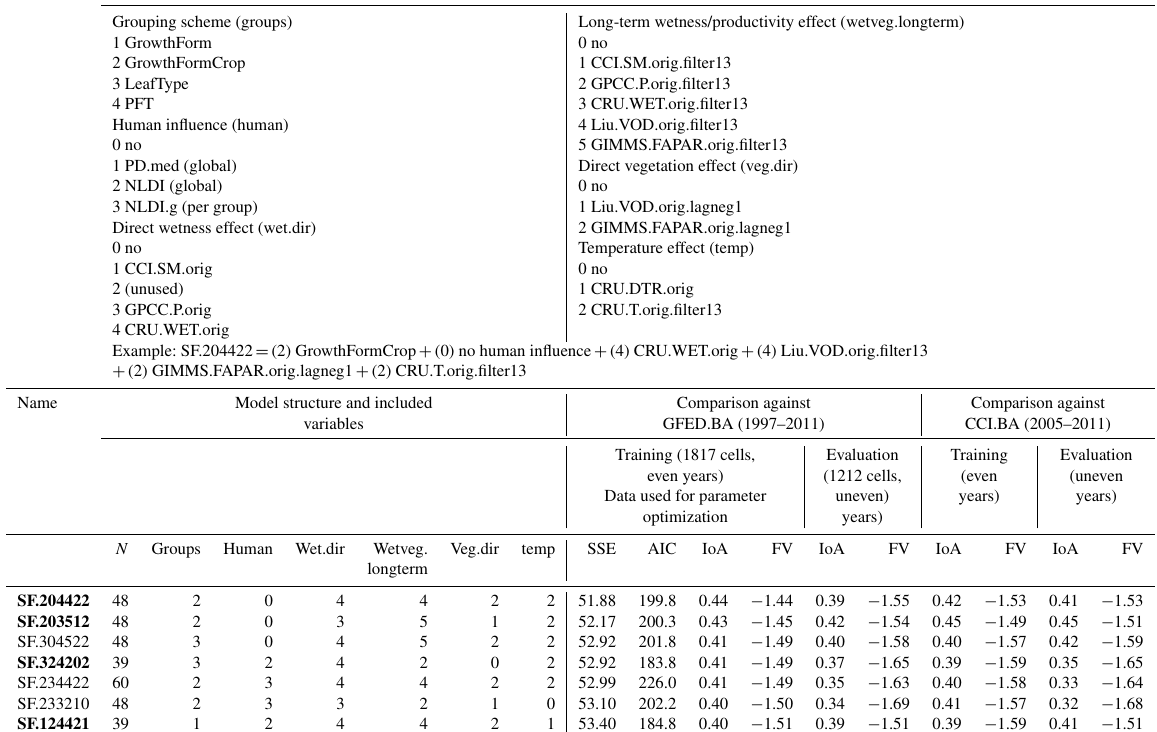
Table A2. Structure and performance of all tested candidate SOFIA models. N denotes the number of model parameters. SSE, AIC, IoA, and FV are based on monthly burned area time series in the optimization and evaluation data subsets from the GFED and CCI datasets, respectively. Model experiments are ordered by SSE. The best SOFIA models (IoA ≥ 0.4 and AIC ≤ 200.5) are highlighted in bold font. Structure of SOFIA models: used control factors and associated variables Grouping scheme (groups) 1 GrowthForm 2 GrowthFormCrop 3